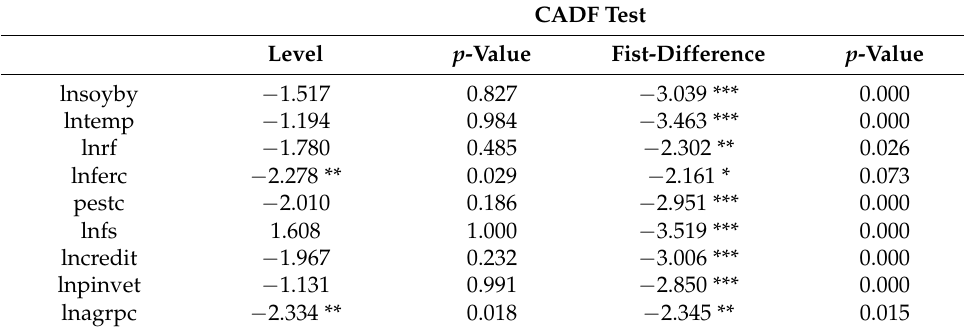
Table 4. Unit root testing results.